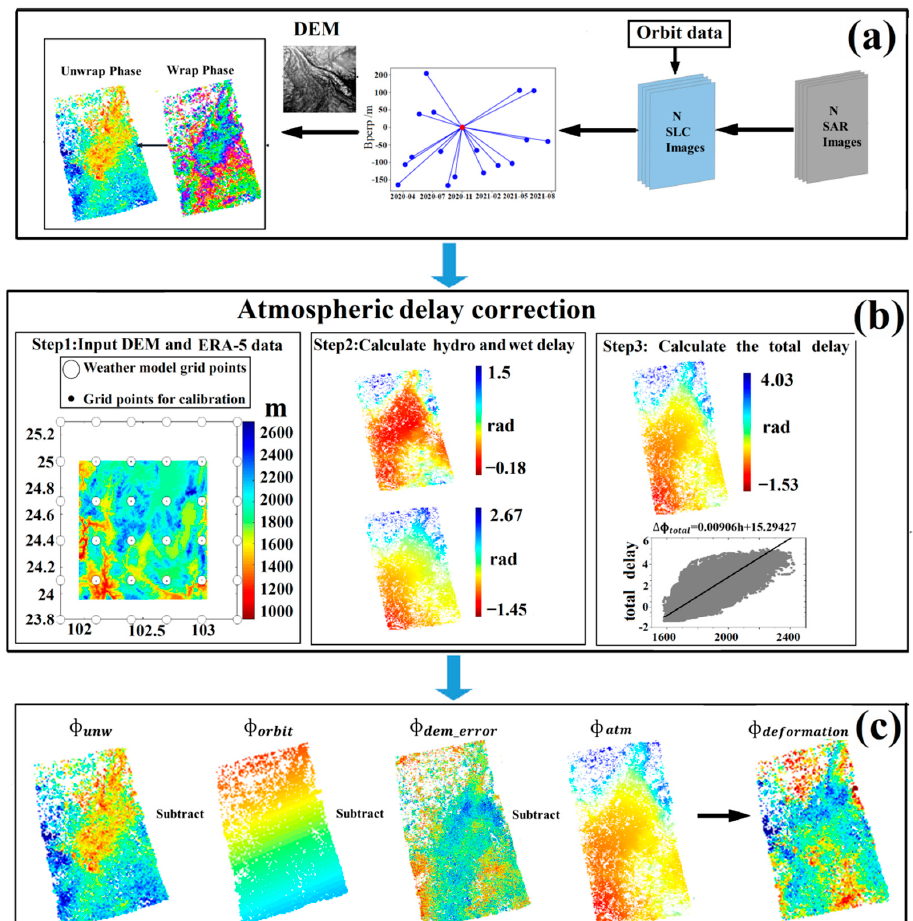
Figure 1. Schematic diagram of atmosphere-corrected time-series InSAR integrated with the latest meteorological reanalysis data. ( a ) D-InSAR flow. ( b ) Atmospheric delay correction flow. In step 1, black circles indicate the location of the ERA-5 grid point at ~27 km and the background is a DEM. Gray scatter plots show the relationship between the atmospheric delay and elevation estimated by ERA-5. ( c ) Time-series analysis flow, where φ unw denotes the original phase, φ orbit denotes the orbital error, φ dem _ error denotes the DEM error, φ atm denotes the atmospheric delay, and φ deformation is the deformation phase.